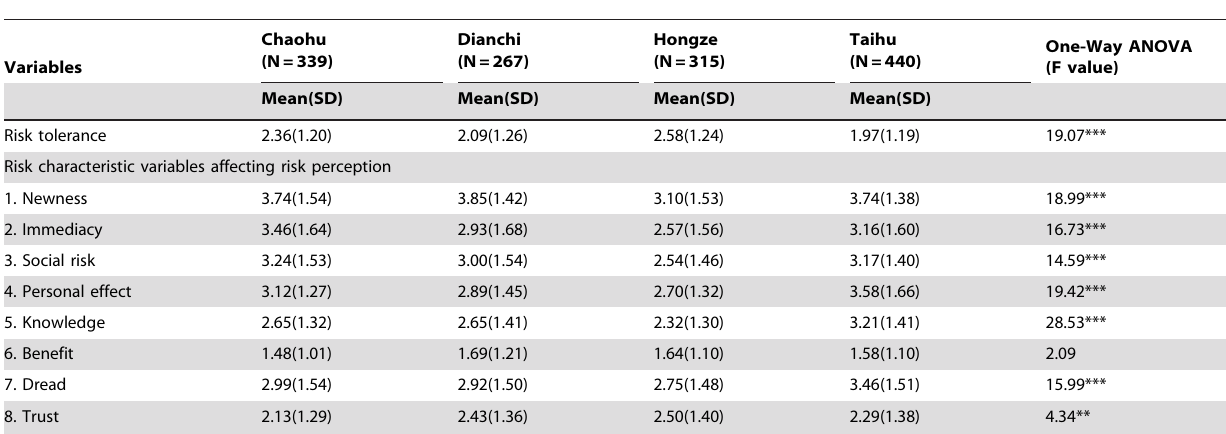
Table 5. Descriptive Statistics of the Risk Characteristic Variables of Four Large Lakes in